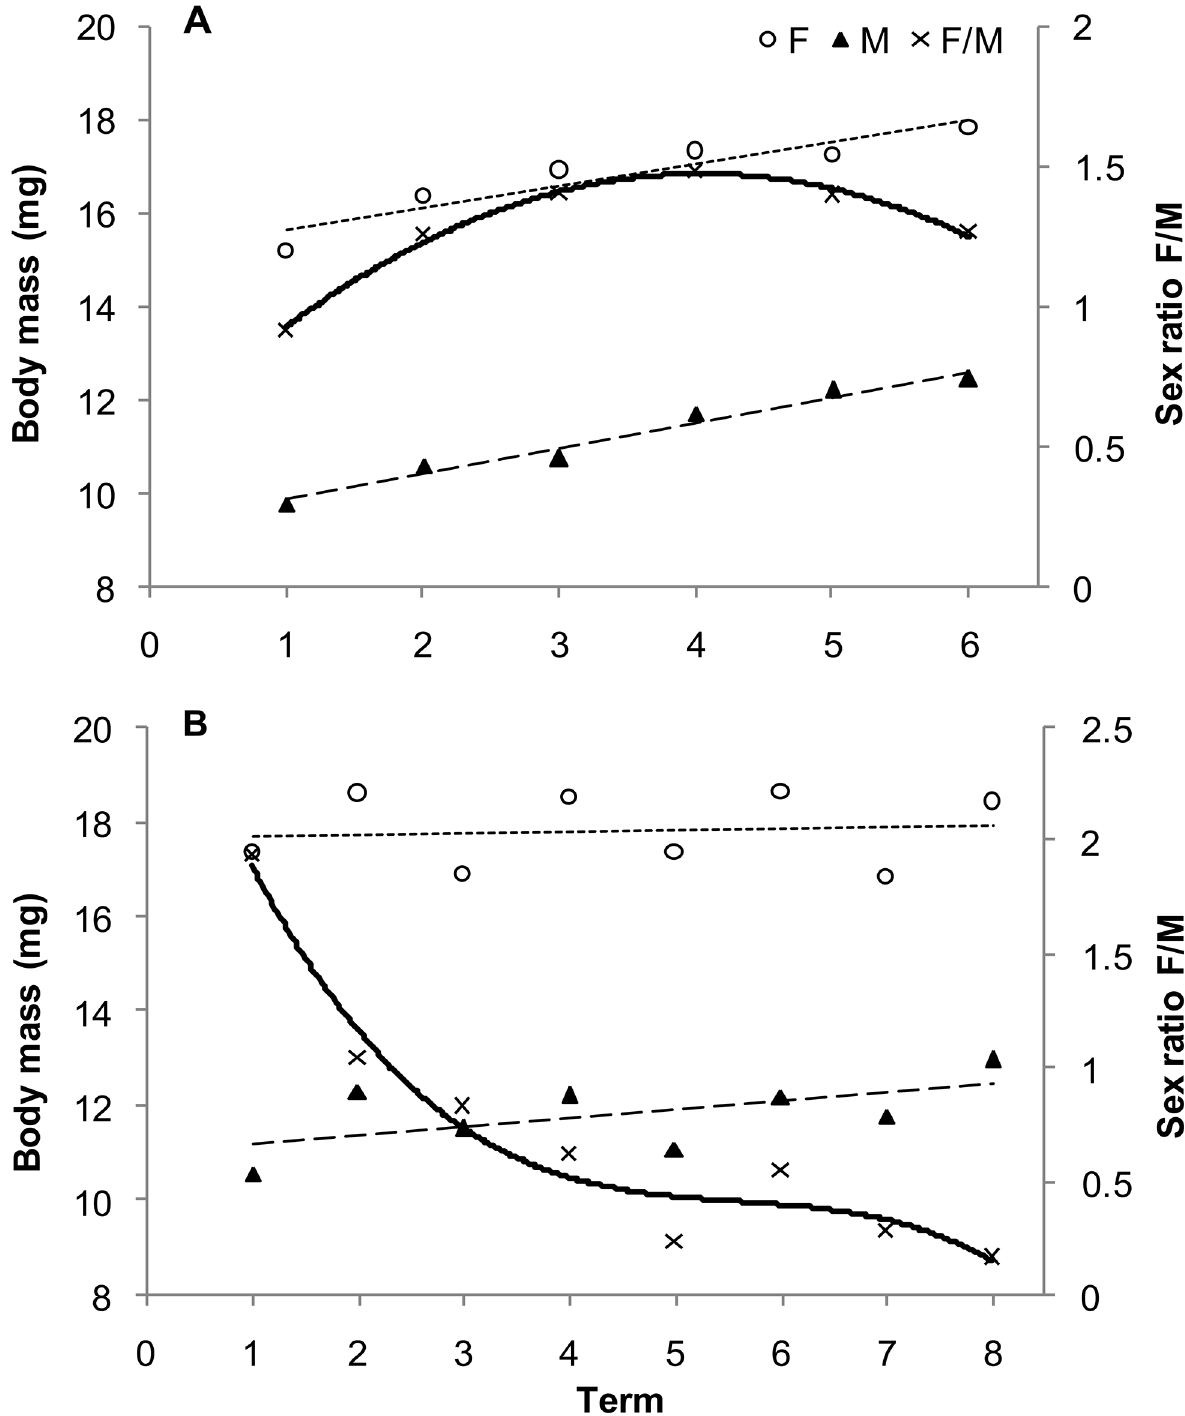
Fig 1. Body mass and sex ratio of current-year (A) and 1-year-old (B) Gonioctena quinquepunctata beetles over time. Numbers 1 – 6 and 1 – 8 indicate successive dates of insect collection (see Materials and Methods). One-way ANOVA was used to determine the effect of term (length of the sampling period) on the body mass of females (current-year, R 2 = 0.1177, P < 0.0001; 1-year-old, R 2 = 0.0895, P < 0.0001), males (current-year, R 2 = 0.2902, P < 0.0001; 1-year-old, R 2 = 0.1882, P < 0.0001), and the sex ratio (current-year, R 2 = 0.1284, P = 0.0986; 1-year-old, R 2 = 0.7117, P <